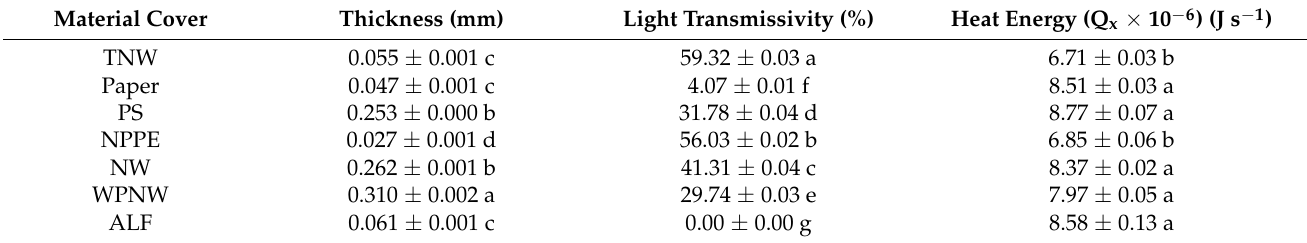
Table 2. Thickness, light transmissivity and heat energy (Q x ) of materials.